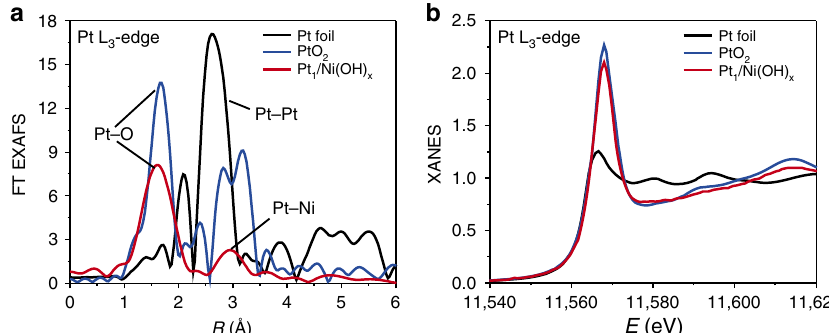
Fig. 2 X-ray absorption spectrometric studies of the Pt 1 /Ni(OH) x catalyst. a Fourier transform EXAFS spectrum of the Pt 1 /Ni(OH) x catalyst in comparison with PtO 2 and Pt foil at the Pt L 3 -edge. b XANES spectra at the Pt L 3 -edge of the Pt 1 /Ni(OH) x catalyst, PtO 2 , and Pt